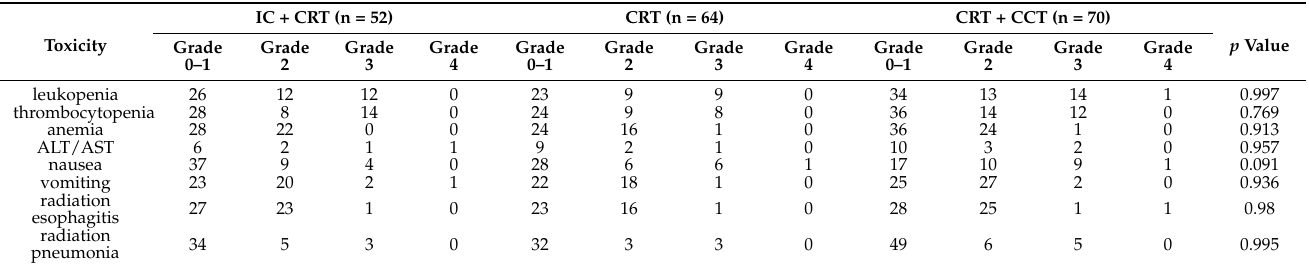
Table 2. Toxicity of patients for IC + CRT, CRT, and CRT + CCT